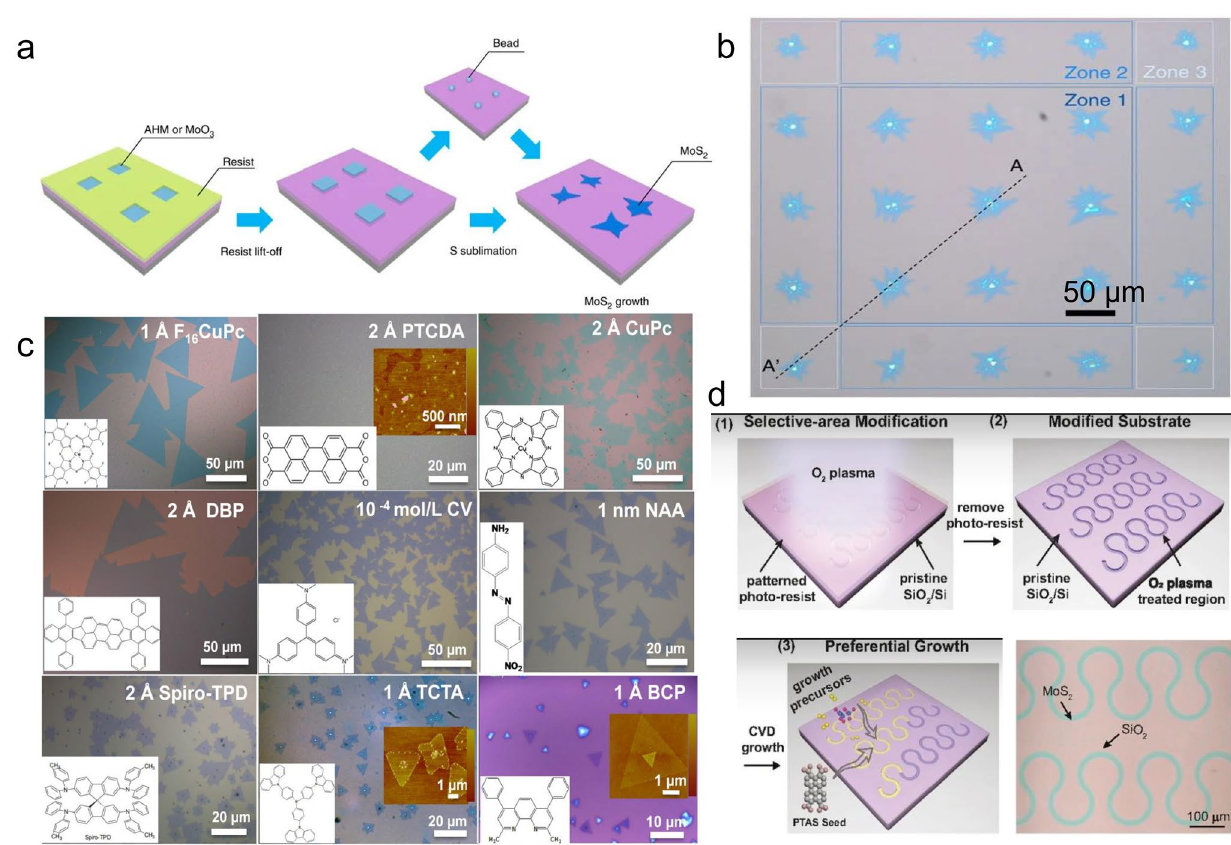
Fig. 9 Growing MoS 2 by using the treated substrate. a , b Precursor has been pre-patterned on the growth substrate [125], Copyright 2015, Springer Nature. c the influence of organic seeding promoter on the MoS 2 growth [27], Copyright 2014, American Chemical Society. d the organic molecular is pre-patterned on the growth substrate [83], Copyright 2019, National Academy of